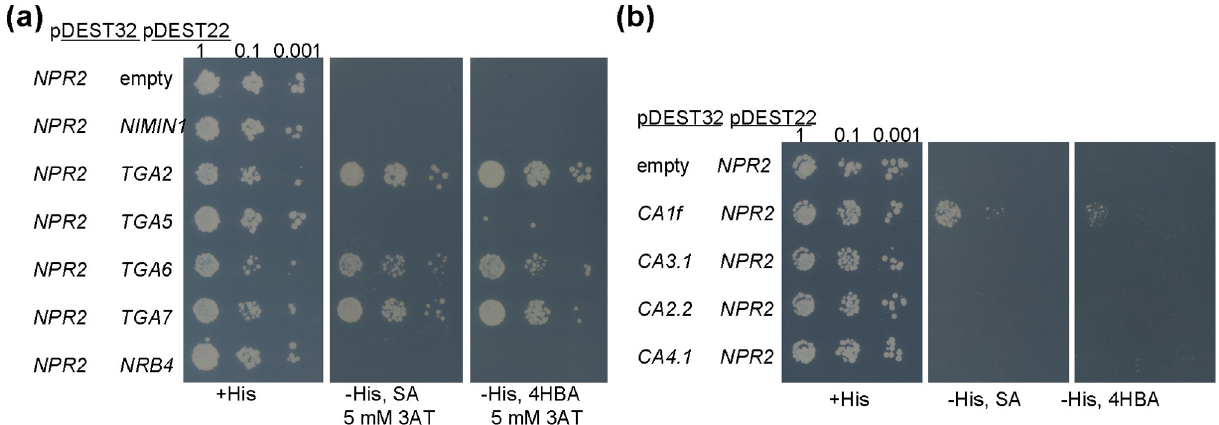
Fig 4. NPR2 interactions. (a) Interactions of NPR2 with proteins that interact with NPR1. Yeast transformed with the indicated plasmids and inserts were grown on three different sets of plates, by depositing a 0.5 μ L drop of OD600s 1, 0.1, and 0.01 (indicated in the top of the first plate). The first plate contained minimal media supplemented with histidine (+His). The second had the same minimal media with no histidine (-His), 100 μ M SA, and 5 mM 3-Amino-1,2,4-triazole (3AT), while the third plate is -His, 100 μ M HBA, and 5 mM 3AT. (b) Interactions of NPR2 with β carbonic anhydrases ( β CAs), as in (a) but without